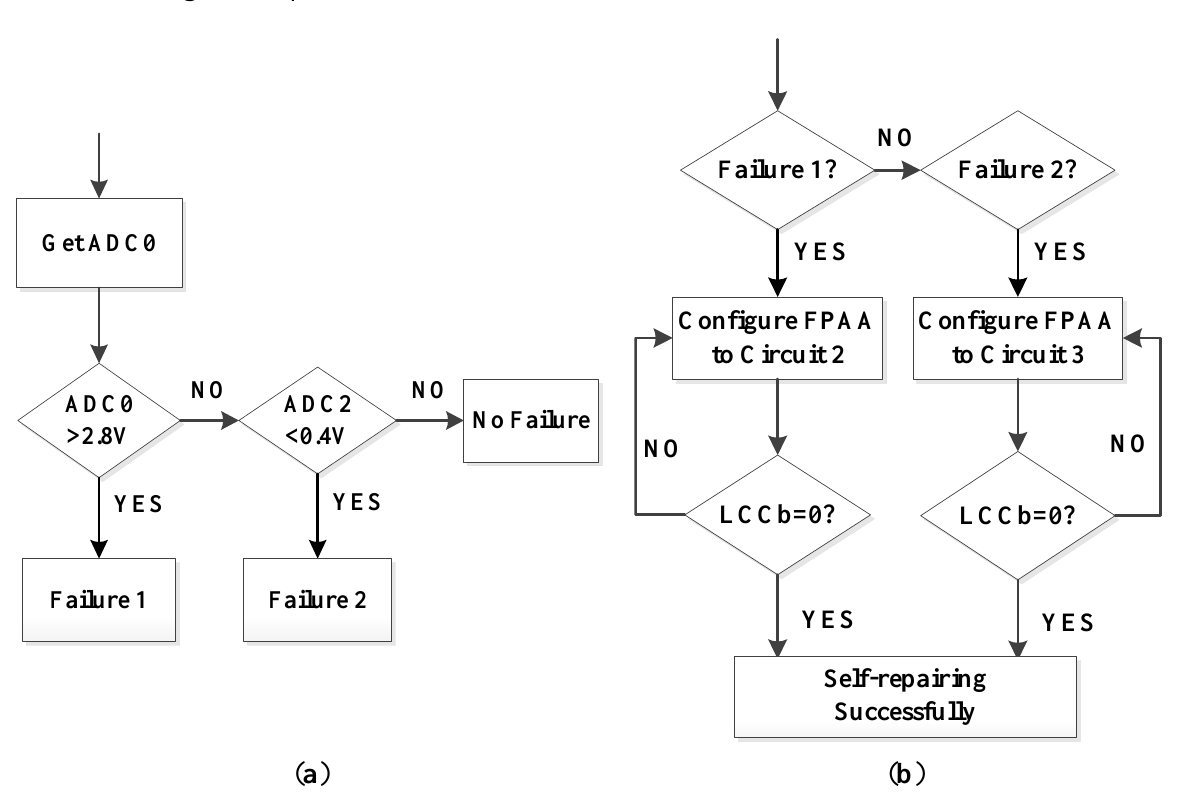
Figure 9. Failure diagnosis and self-healing process: ( a ) Fault diagnosis process ( b ) Reconfiguration process.